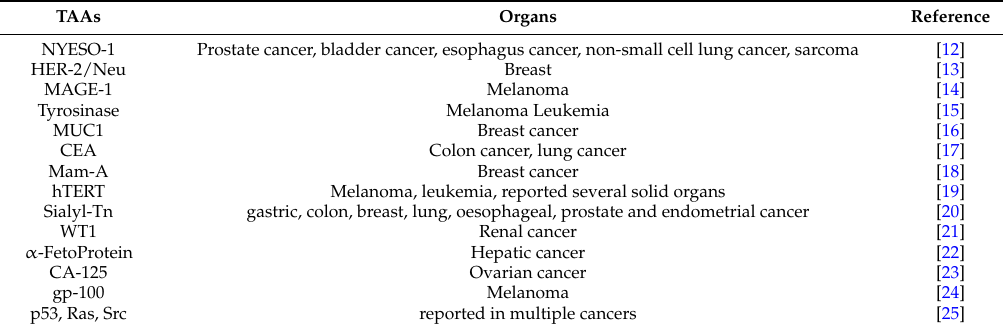
Table 1. List of Human tumor associated antigens potentially applicable for development of DNA vaccines. TAA, tumor-associated